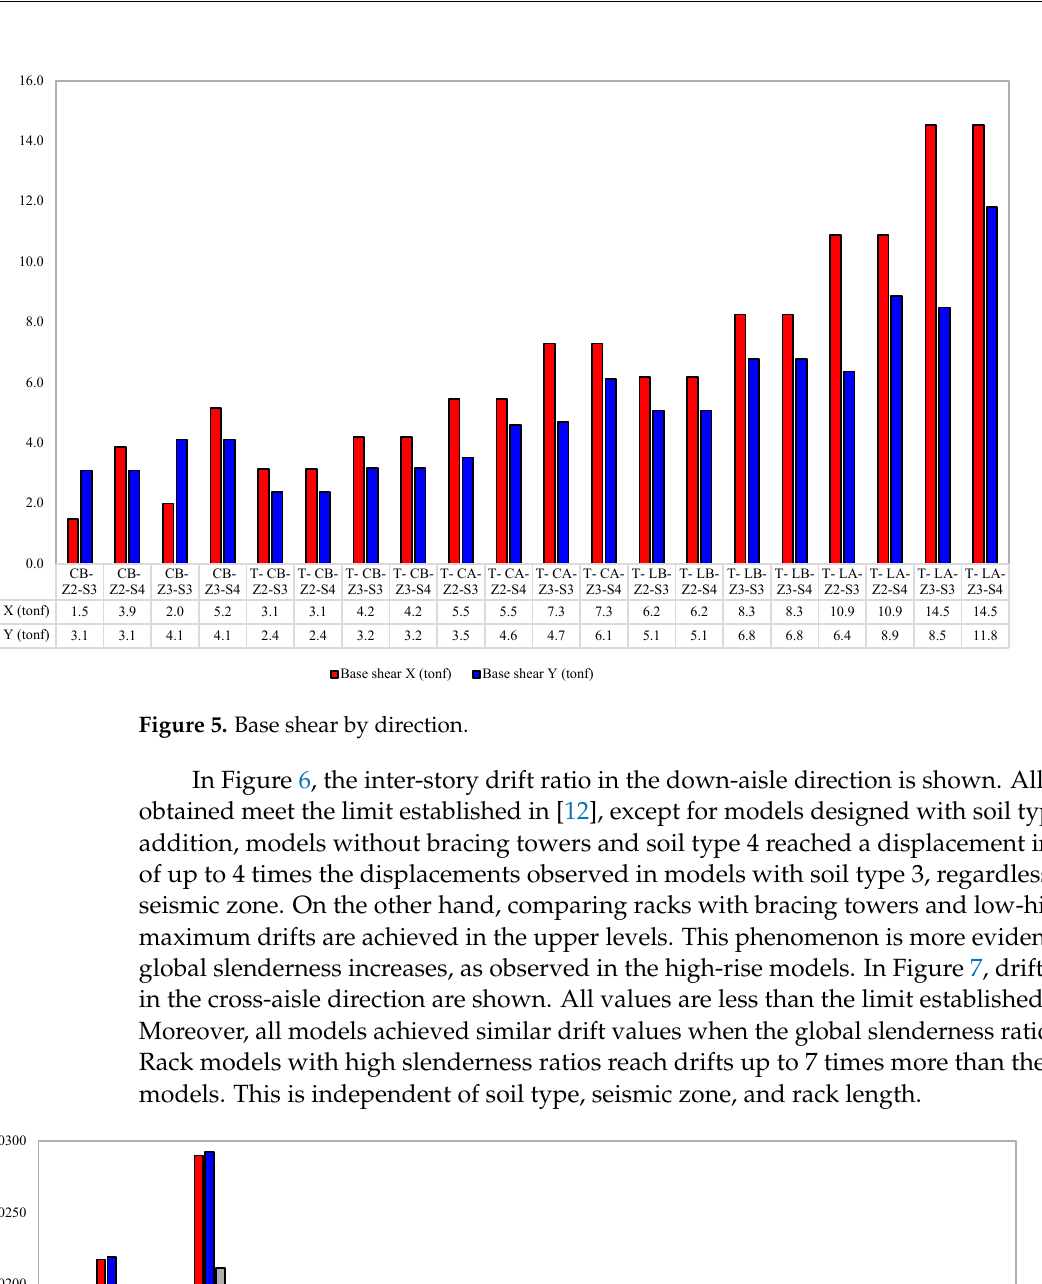
Figure 4. Periods in racks models.